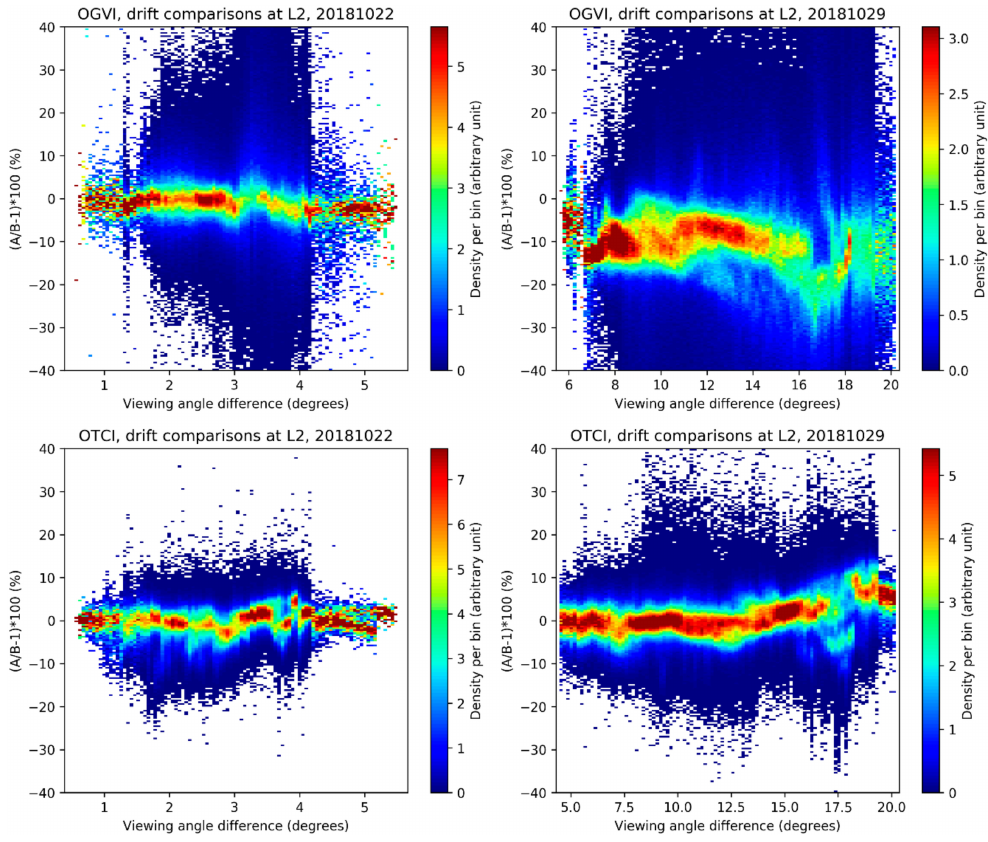
Figure 12. Relative di ff erences of OLCI-A and OLCI-B OGVI ( top ) and OTCI ( bottom ) as function of the viewing angle di ff erence for the two drift dates available in the archive ( left : 22nd October, 3 min apart; right : 29th October, 9 min apart). Density histograms are made per viewing angle bin (size adapted to the